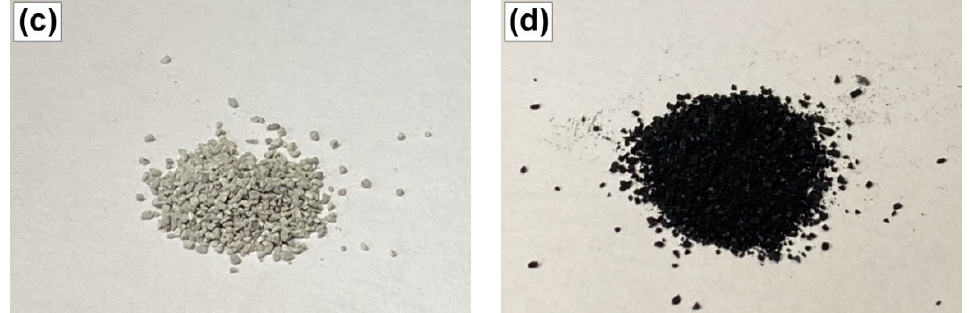
Figure 10. Photographs of the 5%V/C12A7 sample (( a ) as-prepared; ( b ) after TPR-H 2 ; ( c ) after cata- lytic tests in ethane dehydrogenation) and a reference sample 5%V/MgO after catalytic tests in ethane dehydrogenation ( d ).